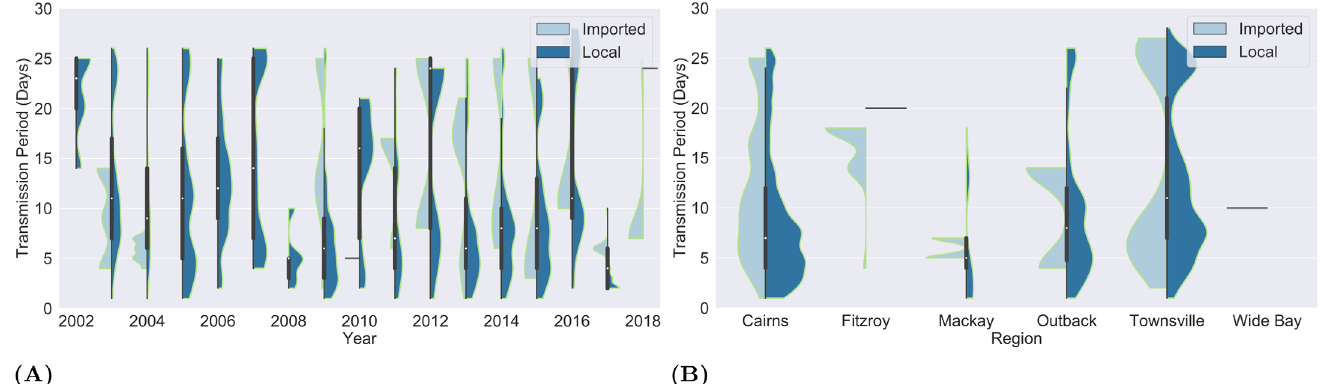
Fig 2. Transmission periods of fertile cases. The violin charts in (A) and (B) depict the length of transmission periods in fertile cases by year and region (SA4) of case occurrence. Each element of the violin chart contains a box and whiskers plot sandwiched by the distribution curves of the transmission periods of imported and locally acquired fertile